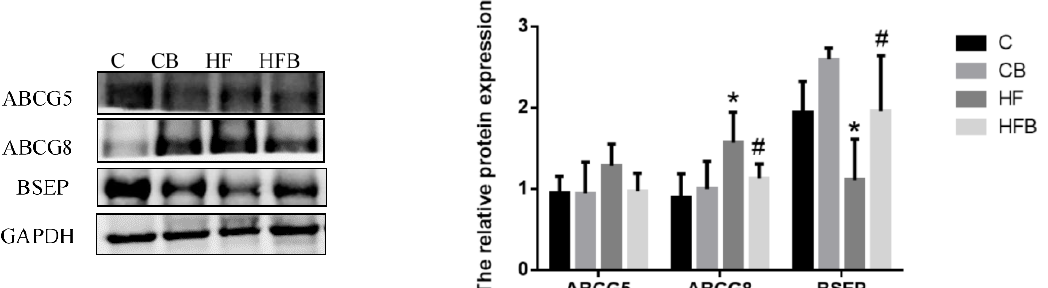
Figure 9. E ff ects of betaine and high-fat diet on factors involving cholesterol excretion in liver of rats ( n = 8). ABCG5, ATP Binding Cassette Subfamily G Member 5 (BET, p = 0.297, FAT, p = 0.242, interaction, p = 0.327). ABCG8, ATP Binding Cassette Subfamily G Member 8 (BET, p = 0.068, FAT, p = 0.011, interaction, p = 0.242). BSEP, Bile salt export pump (BET, p = 0.013, FAT, p = 0.014, interaction, p = 0.704). * Significantly di ff erent from the C group ( p < 0.05). # Significantly di ff erent from the HF group ( p < 0.05). C—basal diet, CB—basal diet supplemented with 1% betaine, HF—high-fat diet, HFB—high-fat diet supplemented with 1% betaine.